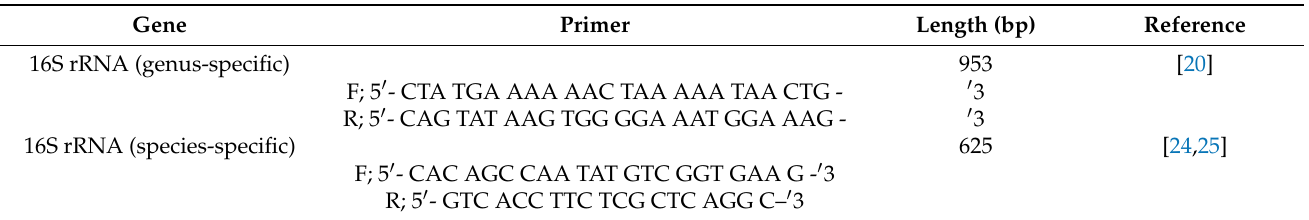
Table 1. Primers used for molecular identification by PCR. Gene Primer Length (bp)